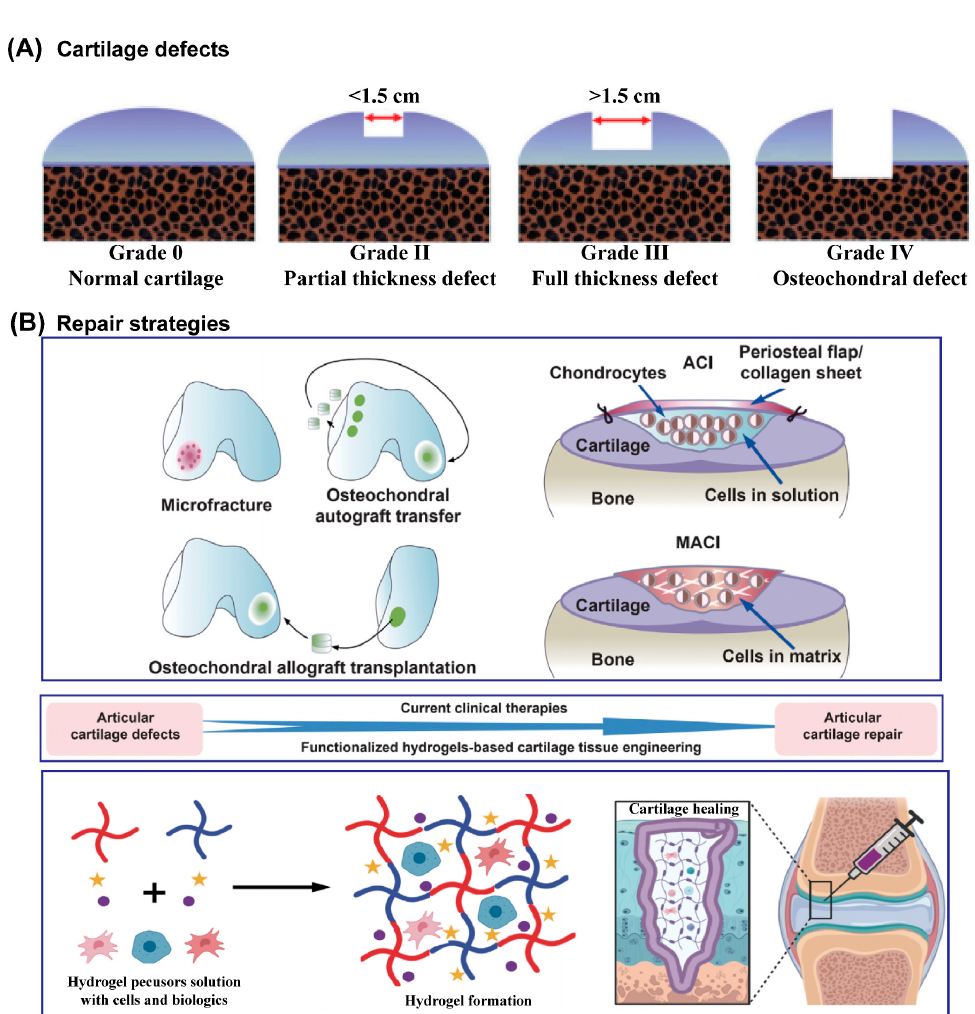
Figure 2. Schematic illustration of ICRS classification system of AC defects ( A ) and schematic diagram of traditionally used clinical repair strategies and hydrogel-based AC tissue engineering for AC defects ( B ). Reprinted with permission from Ref [28]. Copyright 2022, Elsevier.